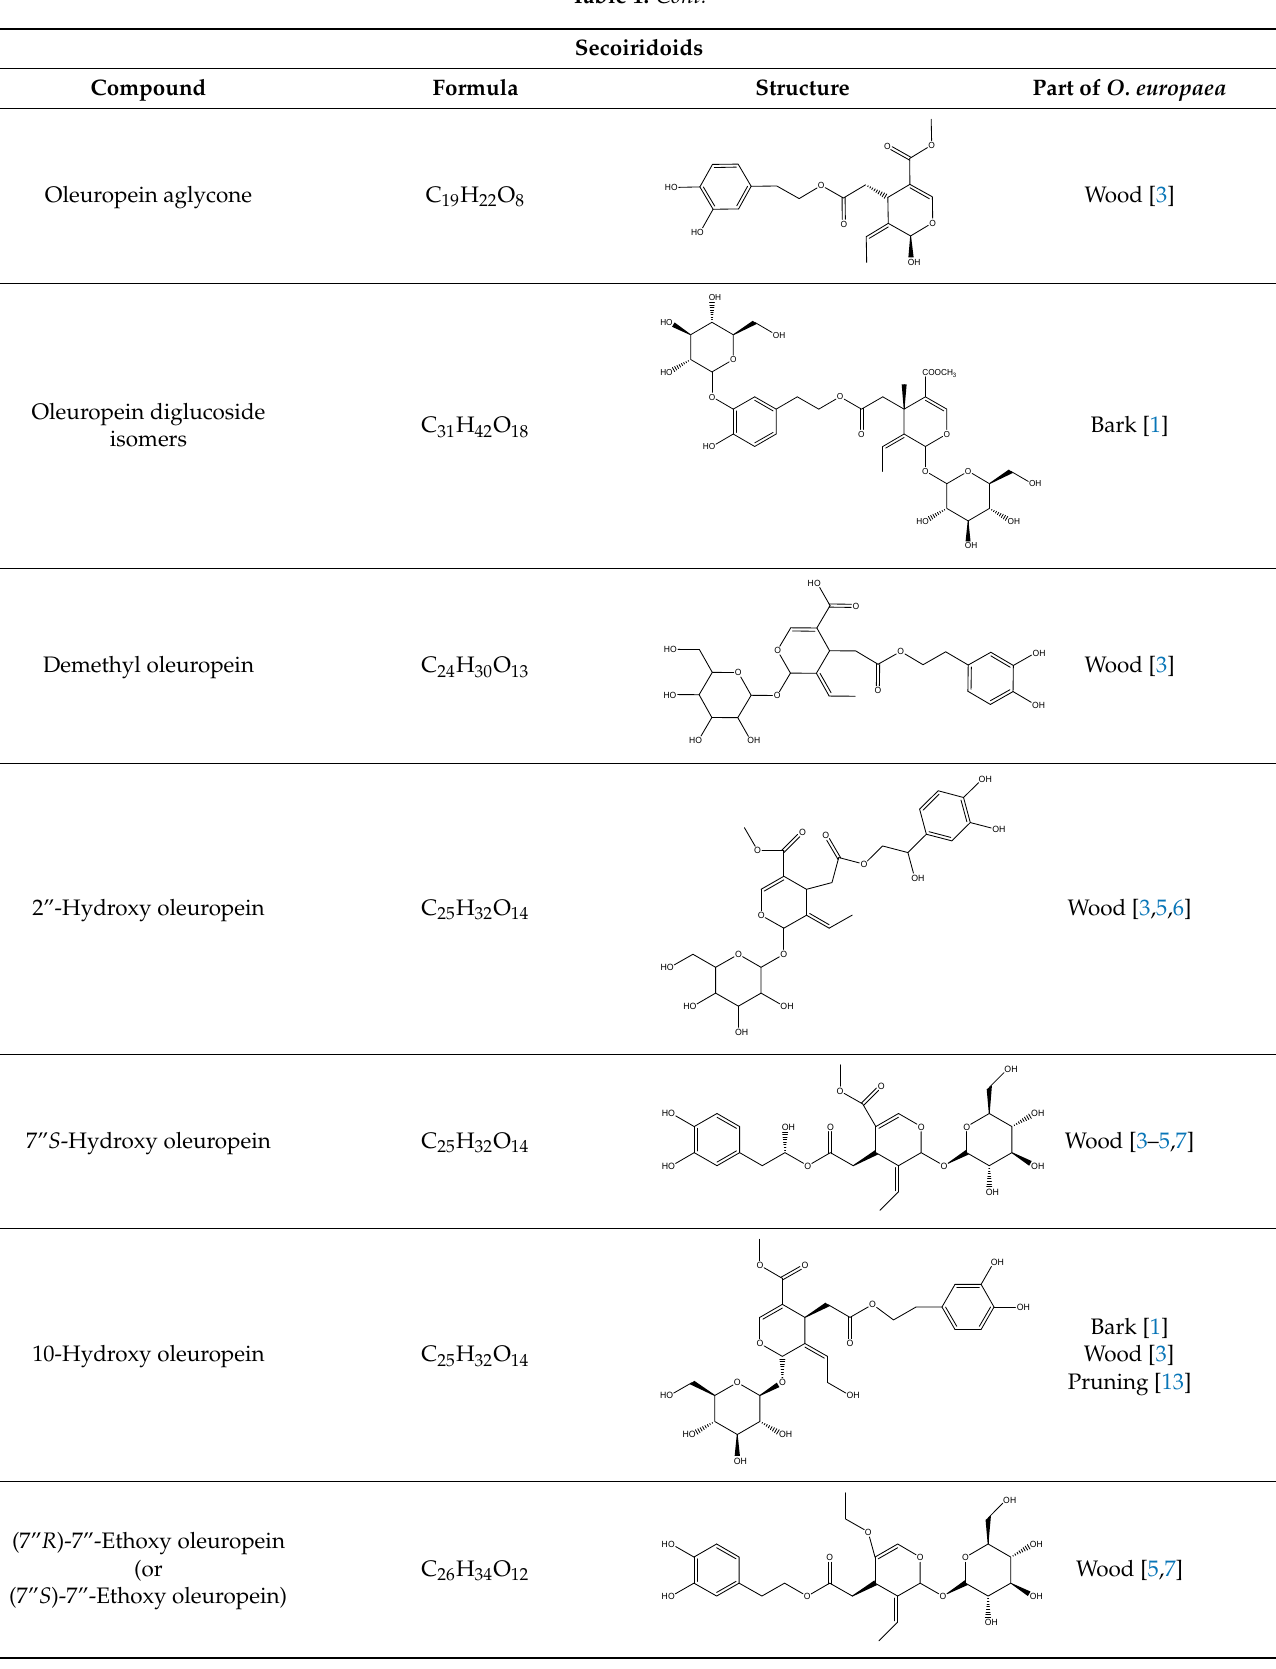
Table 1. Cont. Secoiridoids Formula Structure Part of O.